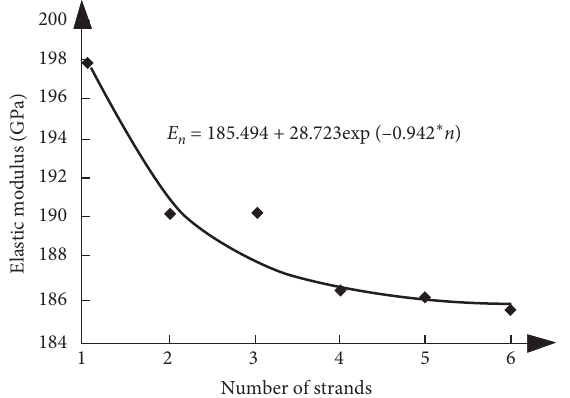
Figure 5: Surface scratch and dislocation produced by sliding extrusion of the constant resistance body.